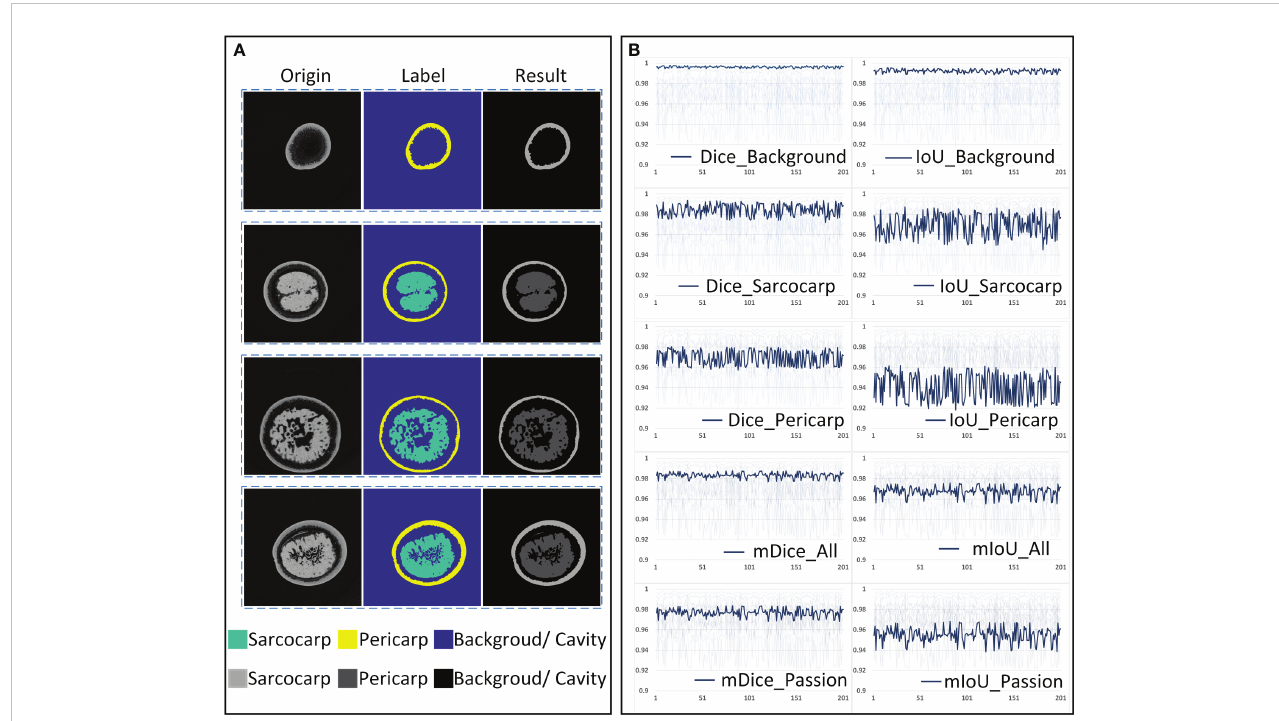
FIGURE 8 The accuracy analysis of the U-net segmentation model. (A) Original tomogram image, its label and segmentation result. (B) Dice and IoU of each category.